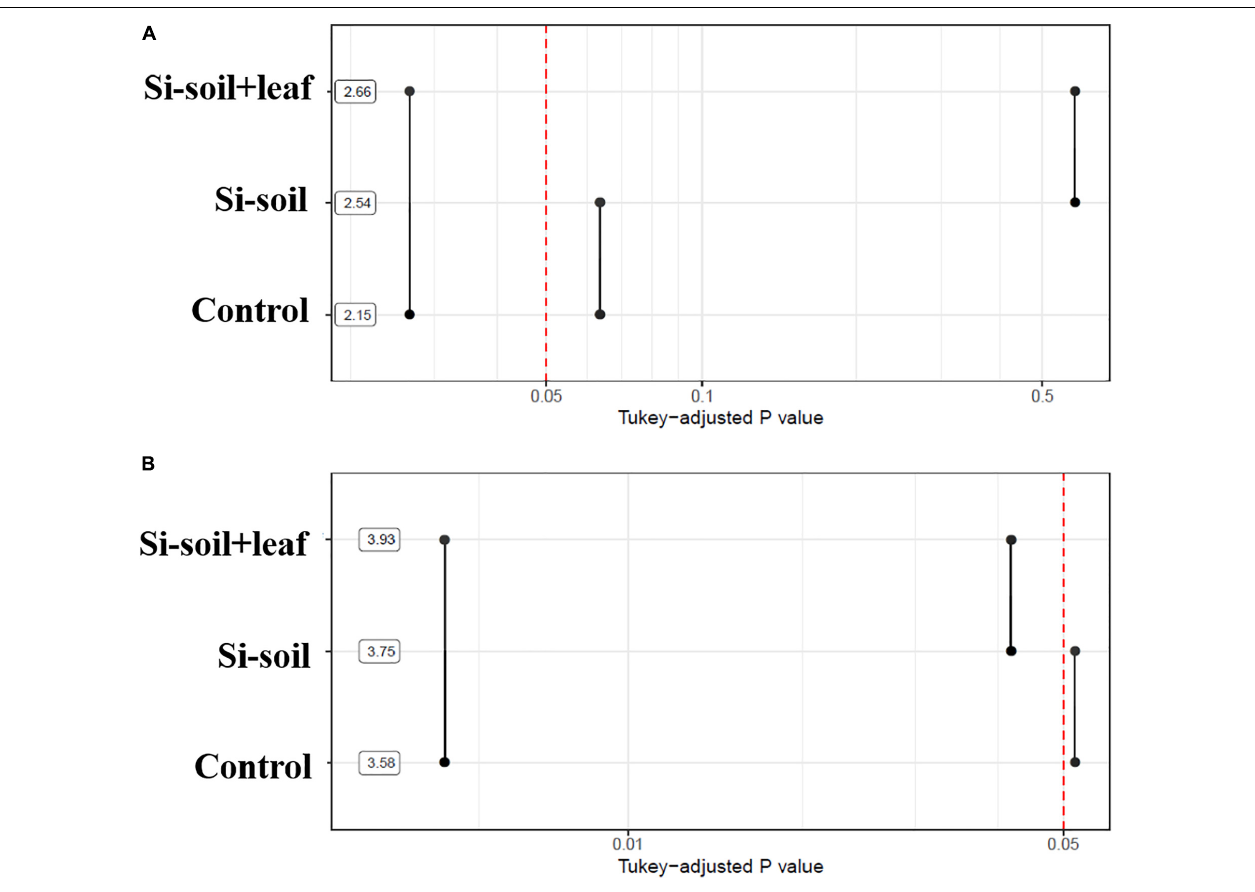
FIGURE 7 | P -values associated with pairwise comparisons of means of treatments for nodules size (A) and nodules counts (B) . Means are shown using a logarithmic